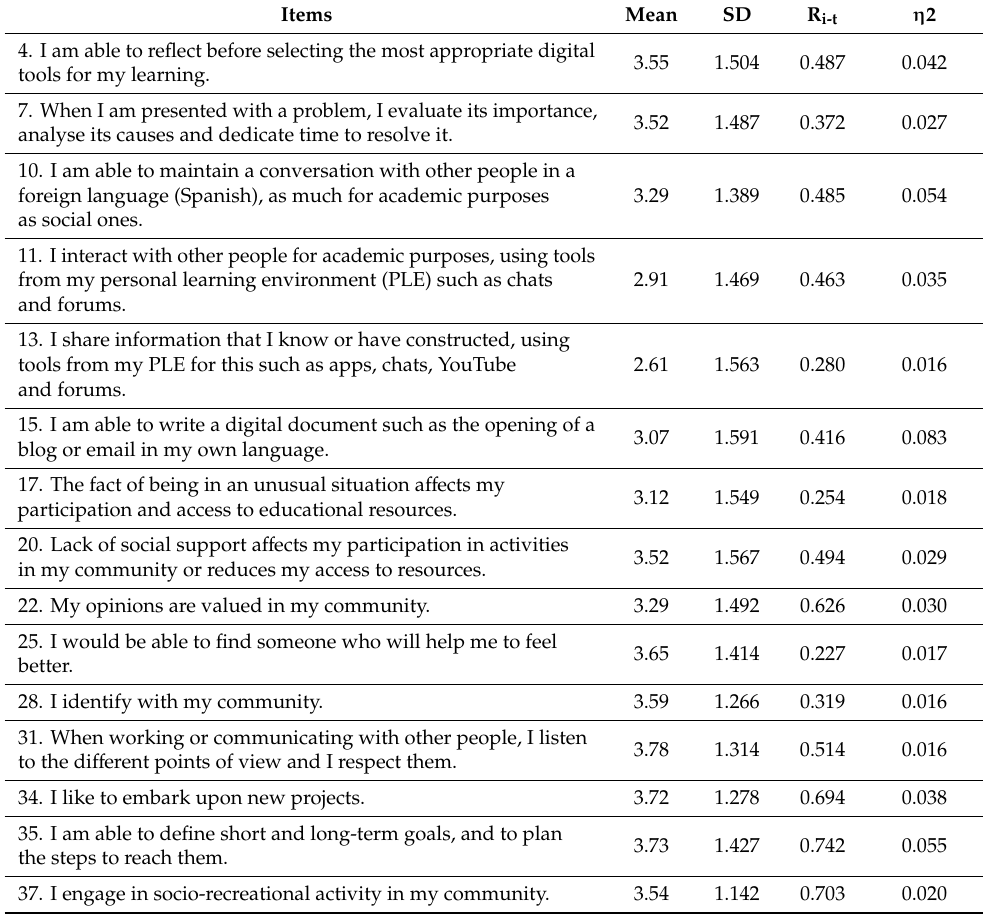
Table 2. Summary of the most representative data with regards to eta-squared y mean, standard deviation and discrimination index obtained after administration of the socio-educational integration strategies questionnaire